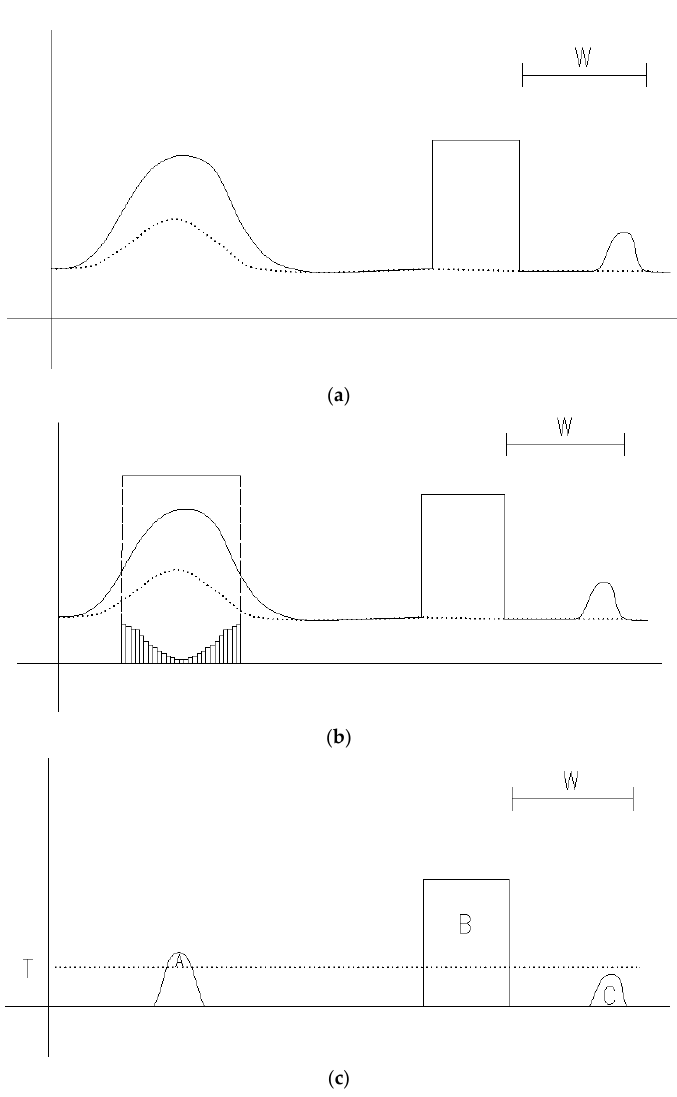
Figure 2. Example of working flow of the proposed method: ( a ) original point cloud (solid line) and interpolated surface (dotted line); ( b ) the terrain slope gradient (small rectangles); and ( c ) filtering results.